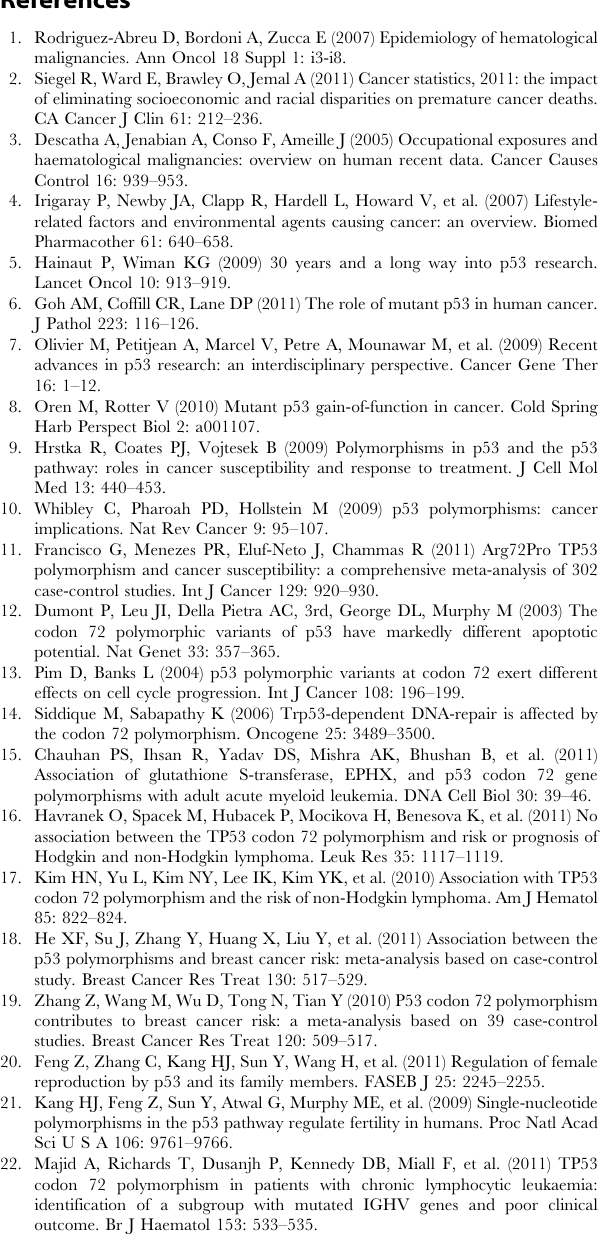
Figure S1 Contour-enhanced funnel plot for publication bias analysis. Table S1 Clinical and demographic characteristics of the patients in each study. Table S2 p53 Arg72Pro polymorphism genotype distri- bution of each study included in the meta-analysis.